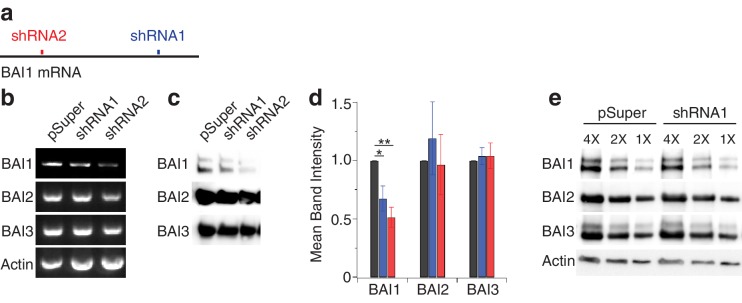
shRNA-mediated BAI1 Kd and effects on other BAIs.(a) Schematic representation of Adgrb1 mRNA showing the sites targeted by shRNA1 (blue) and shRNA2 (red). (b) Results of rtPCR of the indicated targets on RNA isolated from 16 DIV hippocampal neurons to which EGFP and pSuper, shRNA1, or shRNA2 had been introduced on DIV three via calcium chloride transfection. Based on EGFP expression, we estimate that 40–50% of the neurons were transfected. (c) Representative Western blots of the indicated proteins in post-nuclear supernatants of hippocampal neurons like those used for RNA isolation in panel b. (d) Quantification of BAI1-3 band density from repeats of the experiments shown in panel c. Black bars indicate pSuper-expressing samples, blue indicates shRNA1-expressing samples, and red indicates shRNA2-expressing samples. *p<0.05; **p<0.01, N = 4. (e) Serial dilutions of pSuper- and shRNA1-expressing samples indicate a linear relationship between band intensity and protein levels. These samples also show actin as a loading control. Taken together with the immunofluorescence data in Figure 1a, Figure 5a–e, and (Duman et al., 2013; Tu et al., 2018), these data indicate a strong knockdown of BAI1 in transfected neurons. Detailed statistics are found in Figure 1—figure supplement 1—source data 1.10.7554/eLife.47566.004Figure 1—figure supplement 1—source data 1.Statistical summary for Figure 1—figure supplement 1: ANOVA and key Tukey post-hoc tests and N and n values for Figure 1—figure supplement 1d.